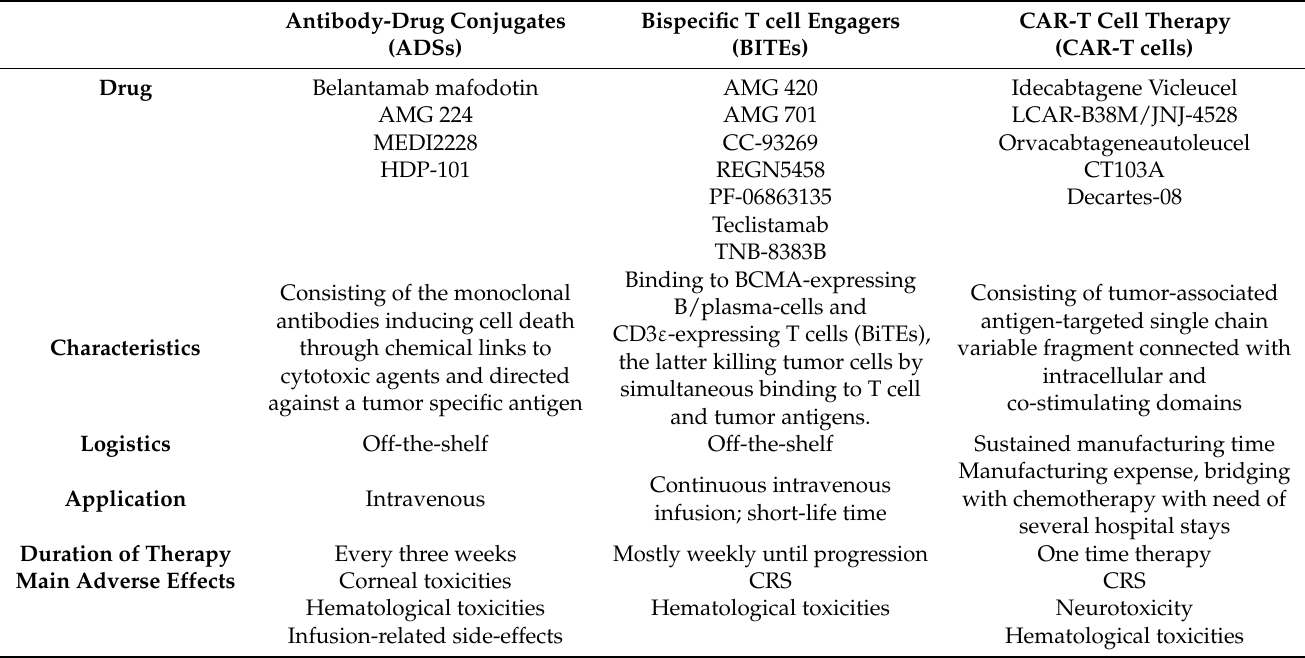
Table 1. Main differences of various BCMA targeted therapies in multiple